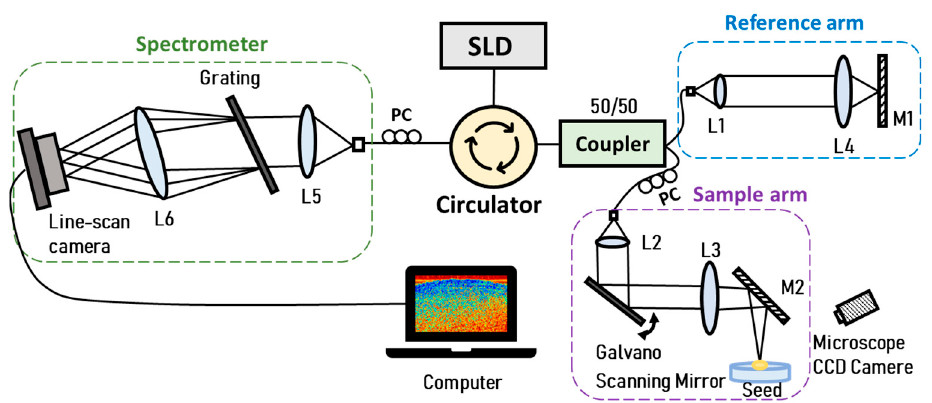
Figure 1. An illustration of spectral domain optical coherence tomography (SLD: superluminescent diode, L1~L6: lenses, M1~M2: mirror, PC: polarization controller). The power of the light incident on the seeds (around 2.6 mW) was below the irradiance damage threshold of the seeds. The beam on the sample was scanned laterally by the Galvano scanning mirror. An area of 3.1 × 1.6 mm 2 was scanned with 2048 ( x ) and 512 ( z ) raster scans at 10 frames per sec (fps), and a total of 100 cross-sectional images were captured. Equation (1) calculated the depth resolution of the system in free space as 6 µ m, and Equation (2) calculated the lateral resolution as 22 μ m;